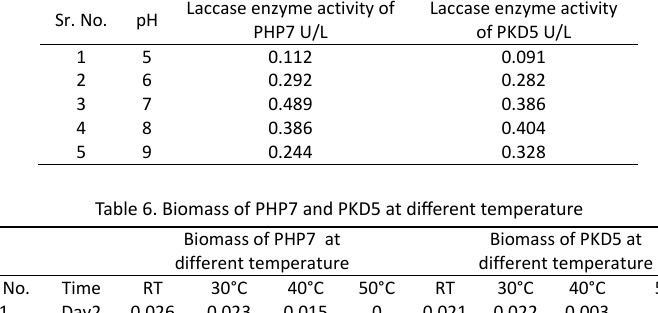
Table 5: Laccase enzyme activity of PHP7 U/L and PKD5 U/L at different pH Table 5. Laccase enzyme activity of PHP7 U/L and PKD5 U/L at different pH Sr. No.